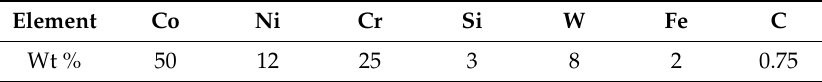
Table 2. Composition of the Co-based alloy